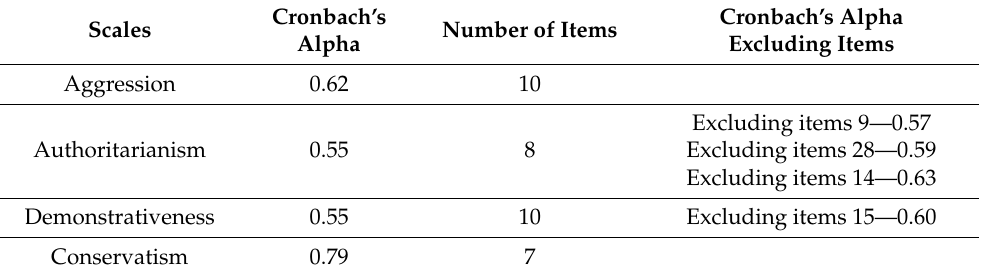
Table 1. The reliability of the occupational deformation